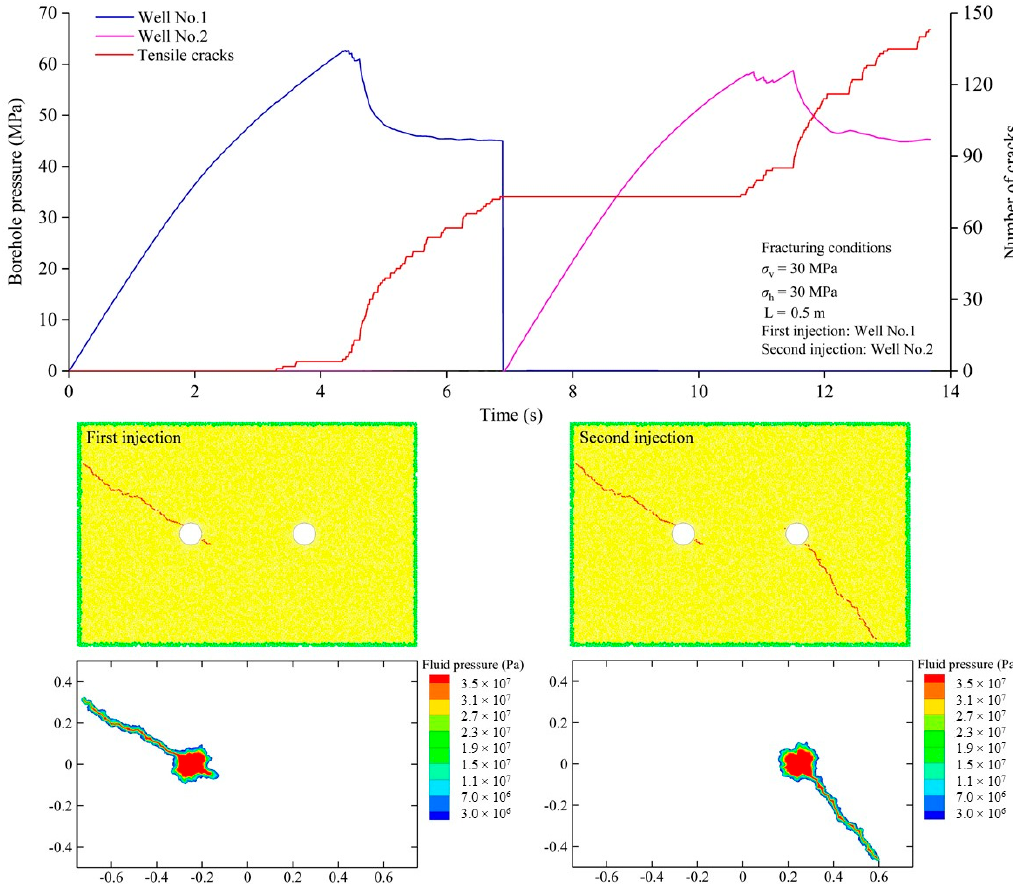
Figure 10. The borehole pressure histories, crack spatial distribution and corresponding fluid pressure field in the asynchronous fracturing (first injection: Well No.1 and second injection: Well No.2) under the hydrostatic pressure condition ( σ v = σ h = 30 MPa).